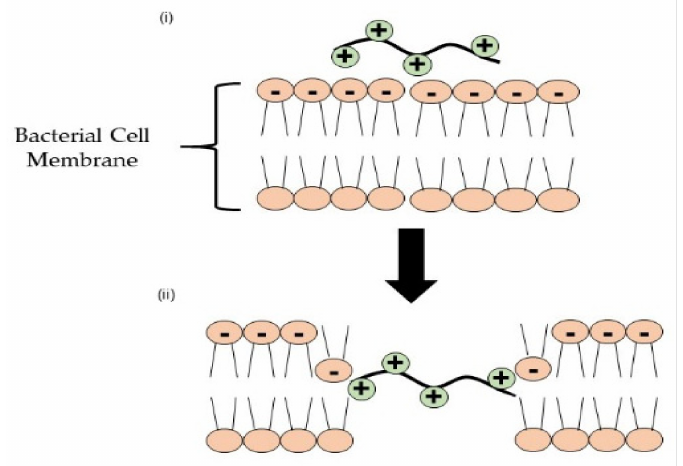
Figure 2. Antimicrobial mechanism of cationic polymer on bacterial cell membrane. ( i ) Adsorption of cationic polymer onto bacterial cell membrane via electrostatic interaction and ( ii ) insertion of cationic polymer into phospholipid membrane bilayer causing translocation of anionic lipids and leading to cell